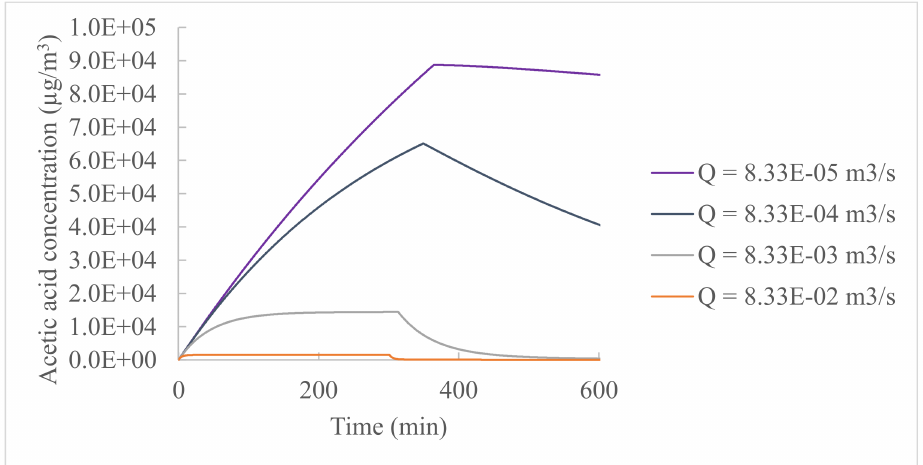
Figure 5. Influence of the airflow rate (Q) on the chemical indoor gas-phase